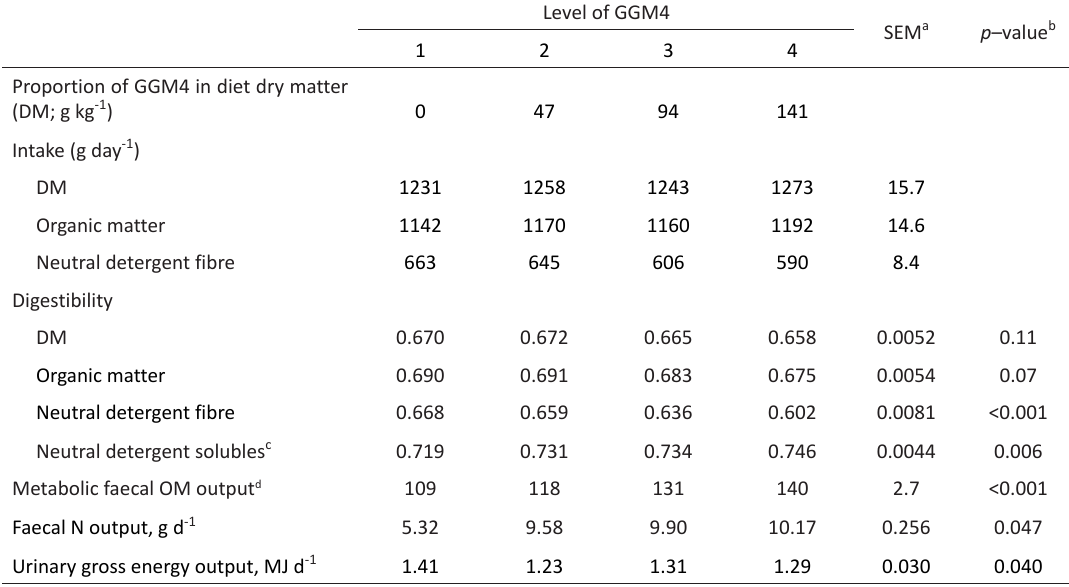
Table 3. Intake and digestibility of hemicellulose extract GGM4 in the digestibility trial using sheep